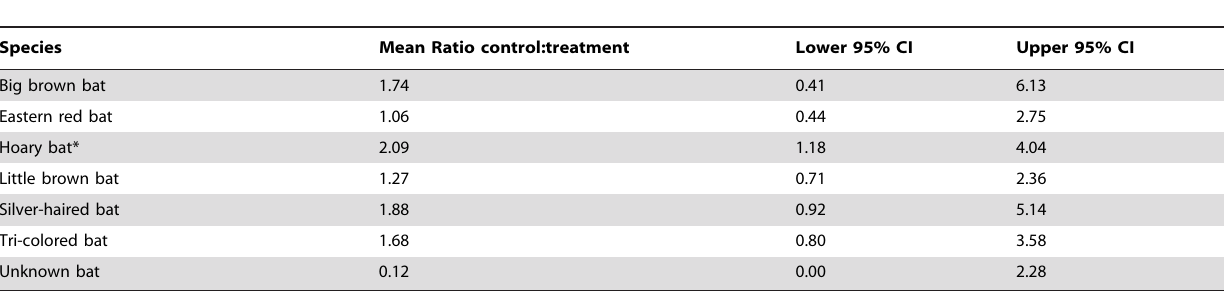
Table 5. Ratio between bat fatalities per control turbine relative to treatment turbines (mean and 95% confidence intervals [CI]) for each species of bat from the Locust Ridge Wind Project in Columbia and Schuylkill Counties, Pennsylvania, 15 August–10